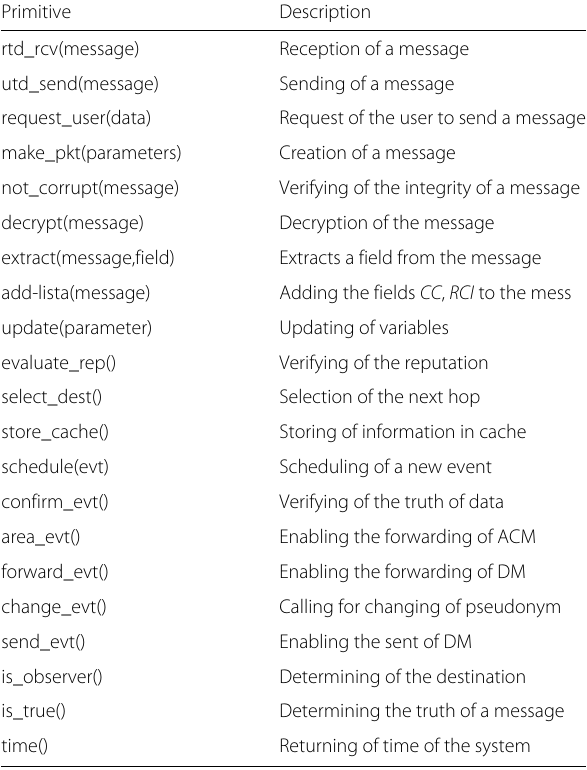
Table 3 Primitives used in the FSM of the